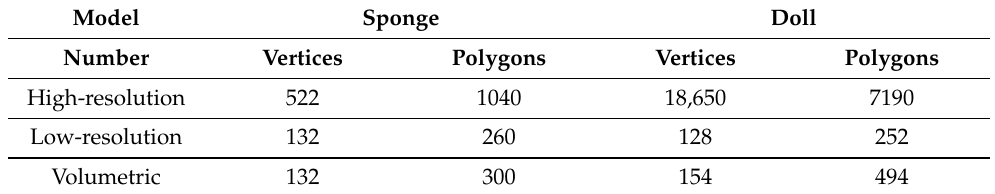
Table 1. Specifications of object